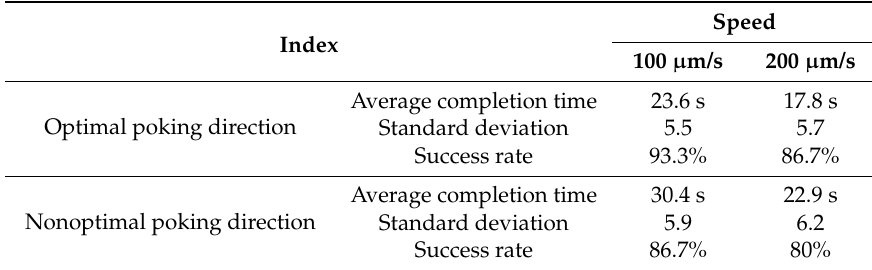
Table 1. The relationship of average completion time, standard deviation, and success rate with the moving speed of the injection